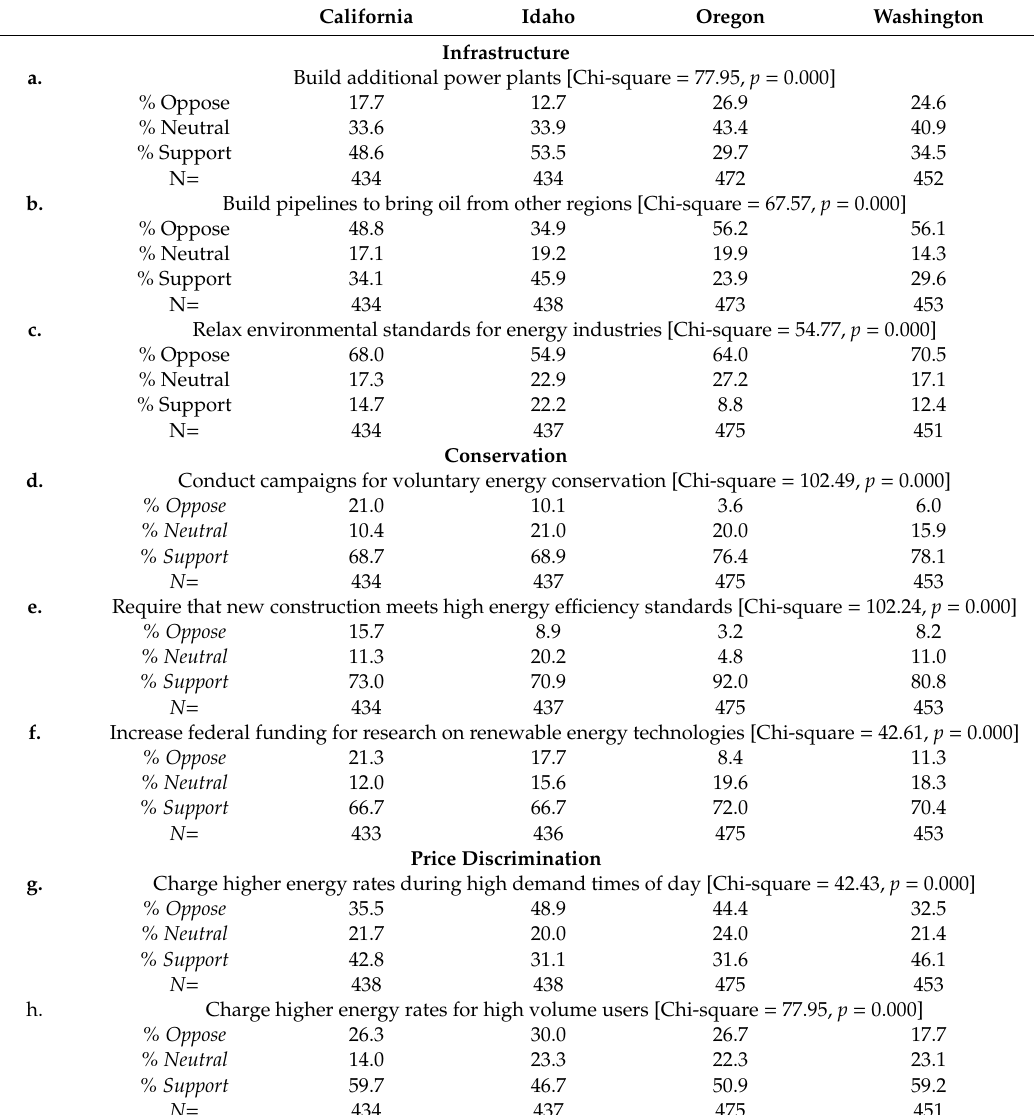
Table 4. Public Support and Opposition to Energy